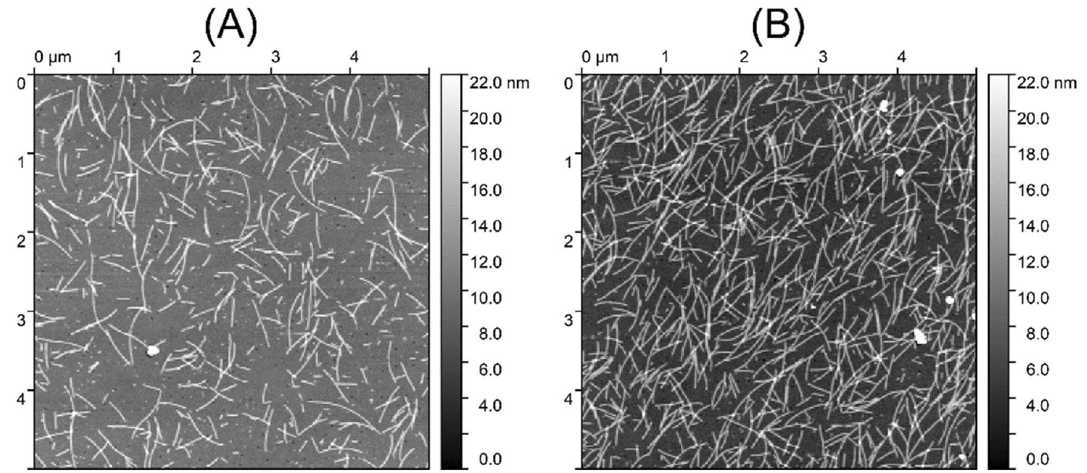
Figure 4. AFM images presented to compare the difference between the number of filaments bound to the gold surface without ( A ) and with ( B ) covalent bonds formed after activating the gold by DSP reagent. The vertical scale from the darkest to brightest points is 22 nm as shown in the color